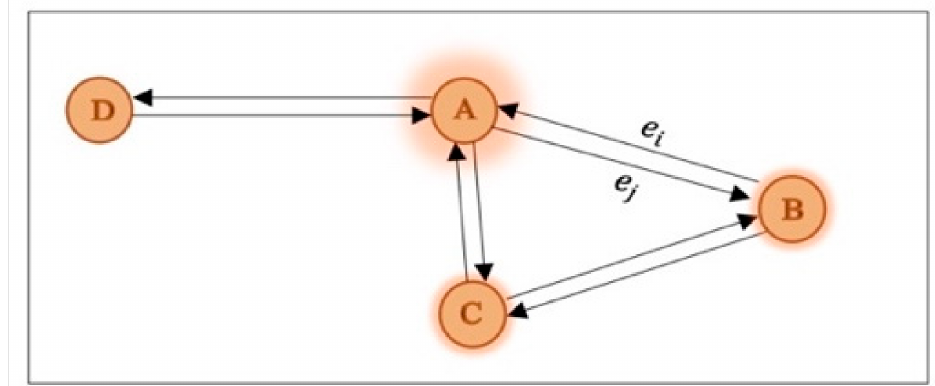
Figure 9. Undirected graph converted into a directed